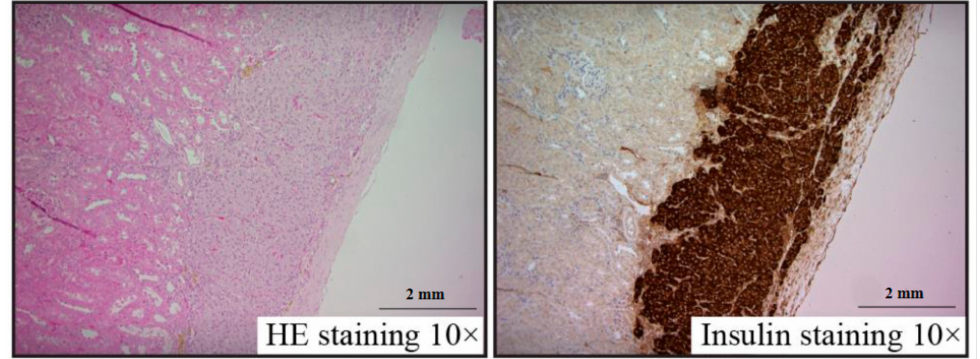
Figure 4. Islet graft histology at 28 days after